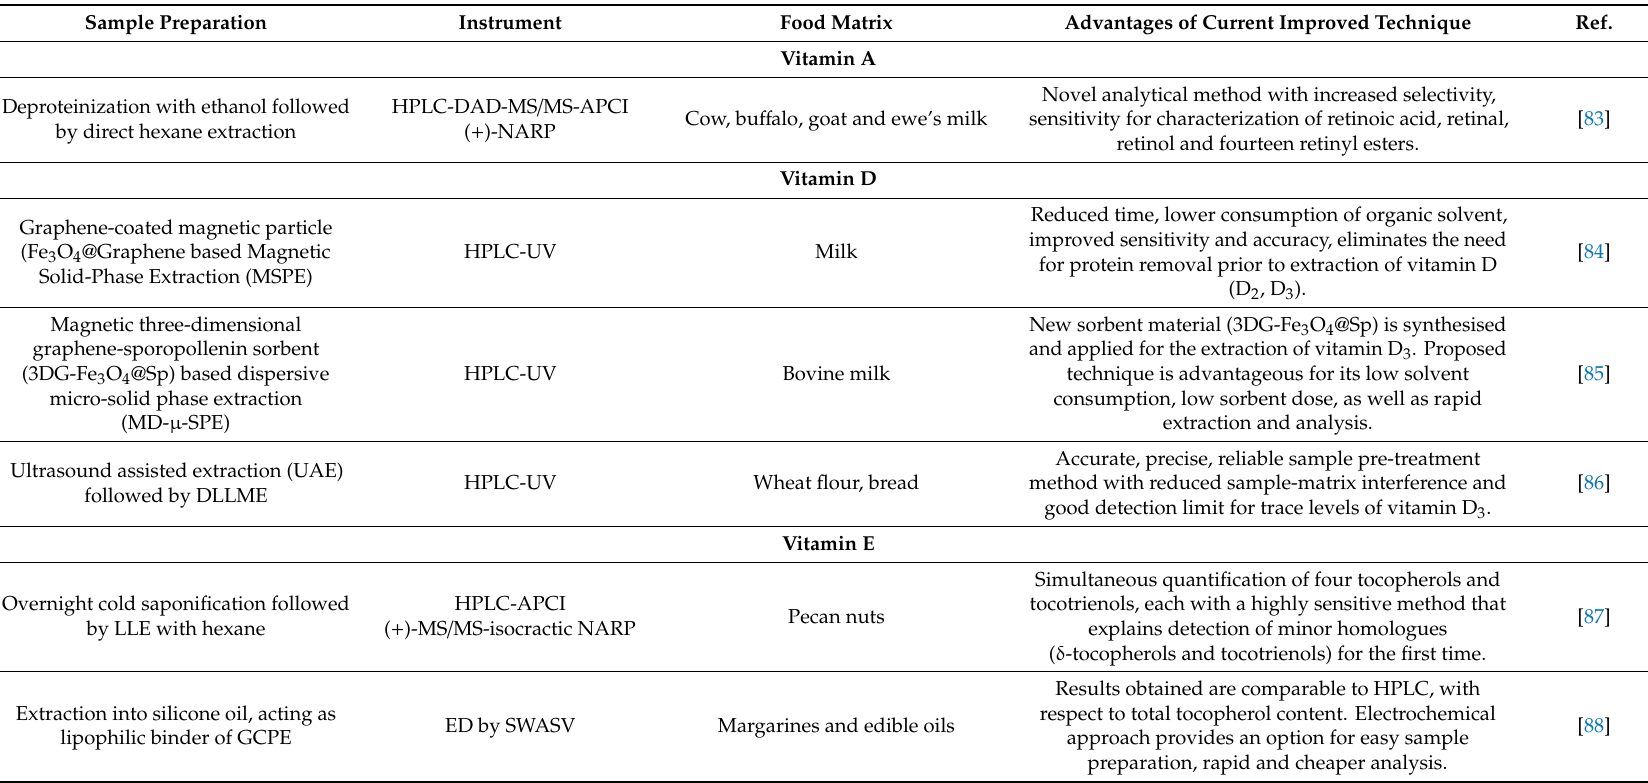
Table 3. Methods, food matrices and advantages of current improved technique for fat soluble vitamins and